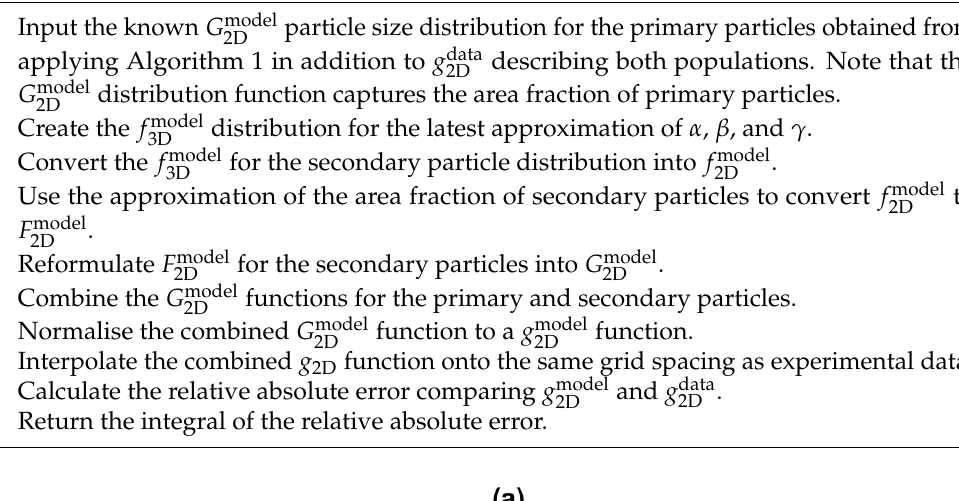
Algorithm 4 Simultaneous bimodal 3D → 2D approximation using g space